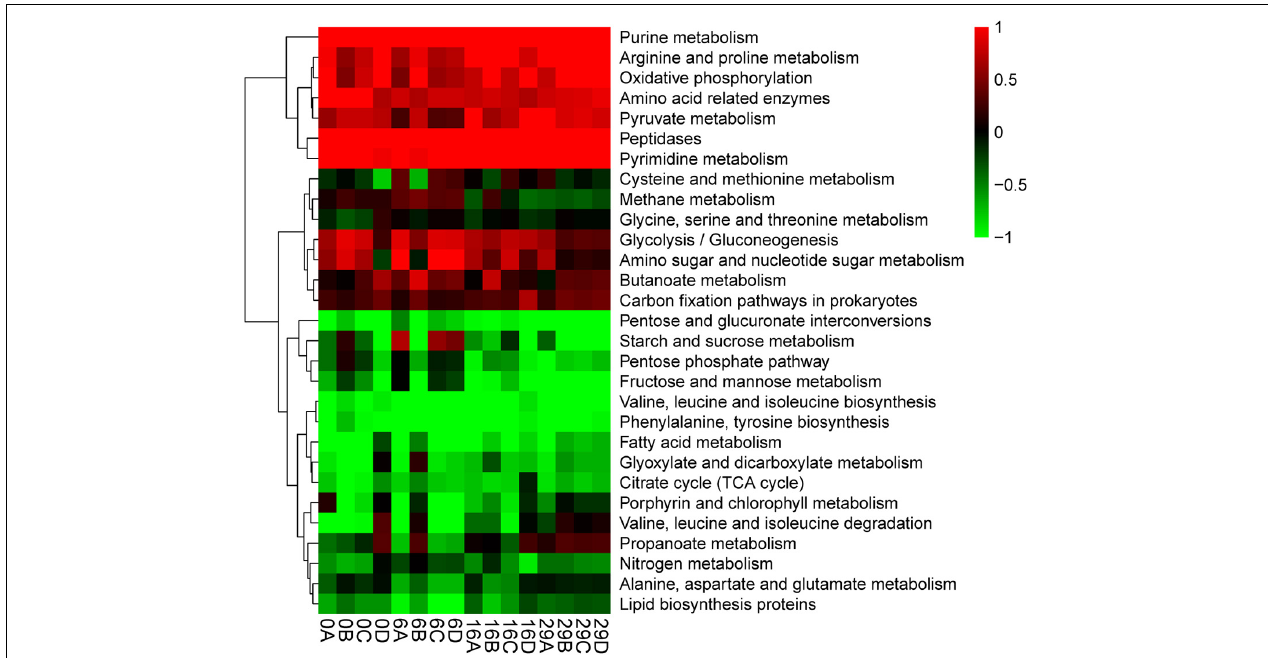
FIGURE 4 | Potential function prediction (based on the level-3 pathway in metabolite of KEGG